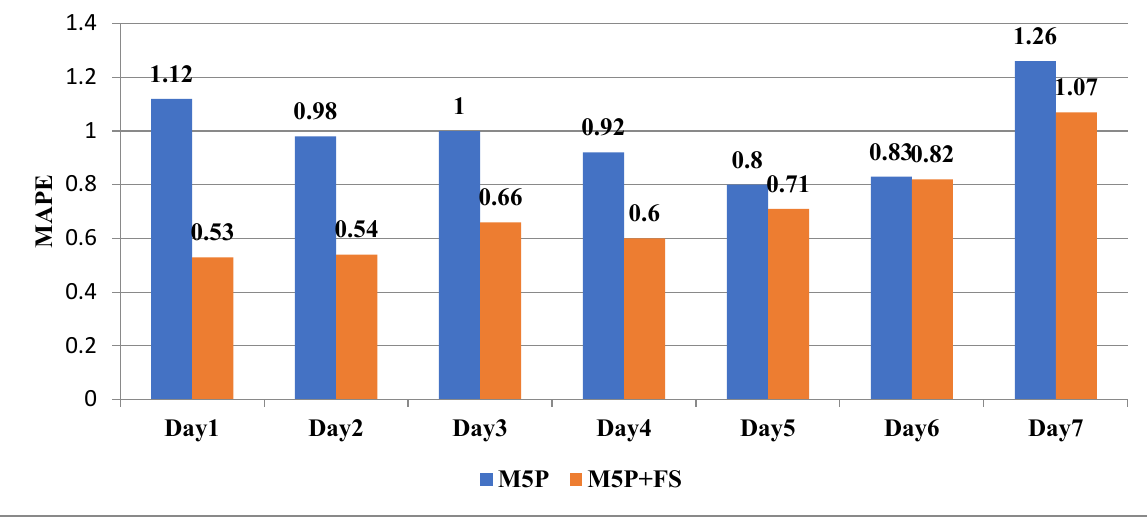
Figure 8. Representation of daily MAPE for spring season corresponding to M5P and M5P + FS.